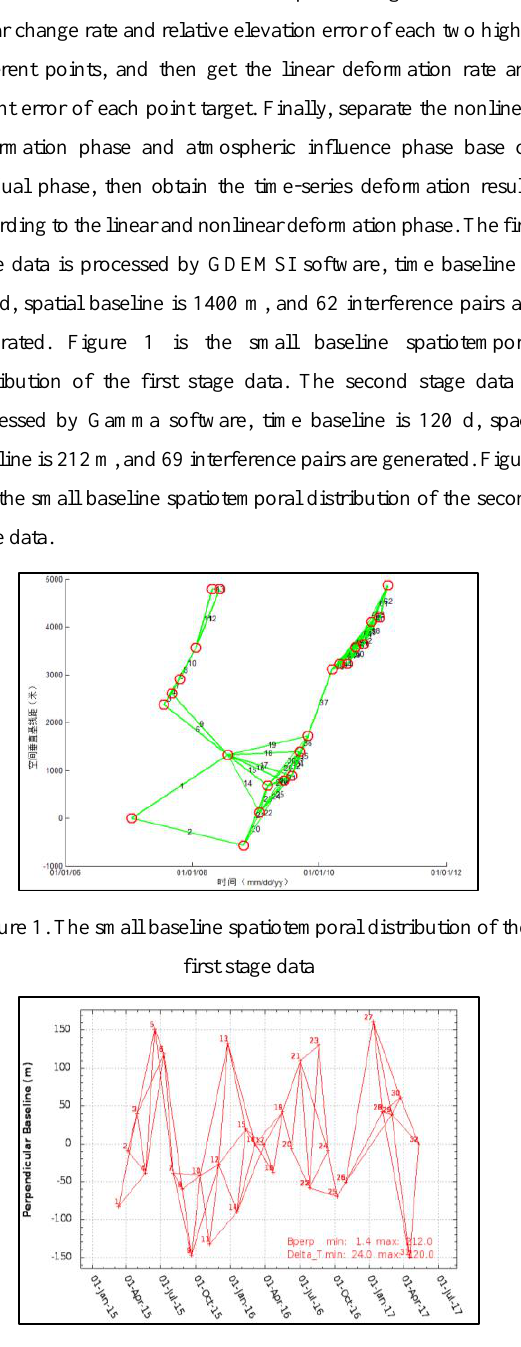
Figure 2. The small baseline spatiotemporal distribution of the second stage data